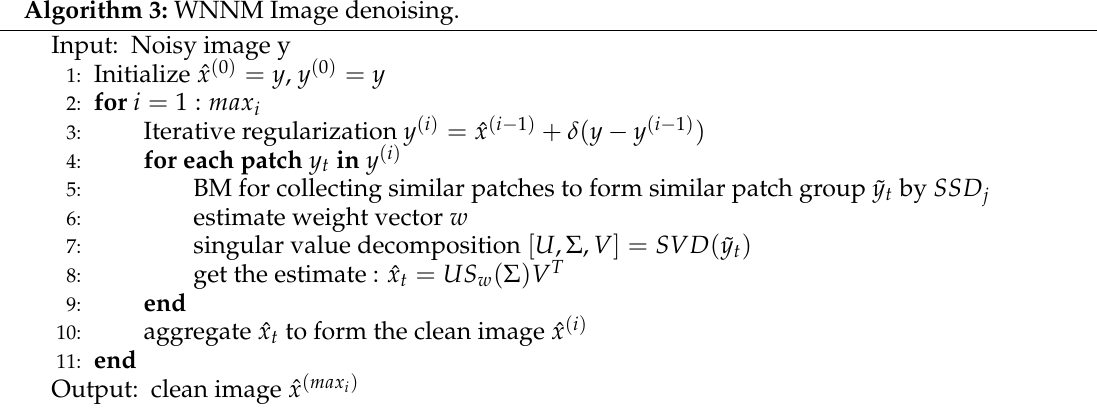
Algorithm 3: WNNM Image